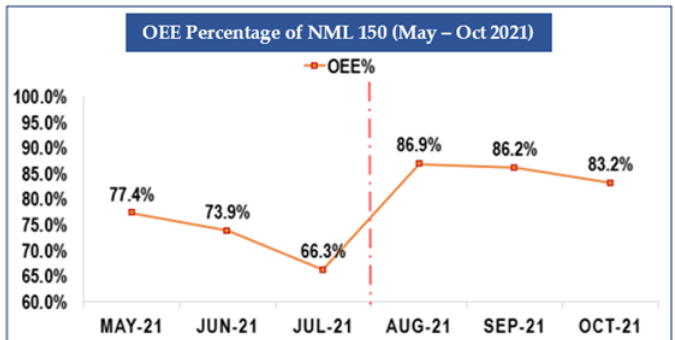
Figure 12. OEE of NML150 tube filling machine from May 2021 – to October 2021.